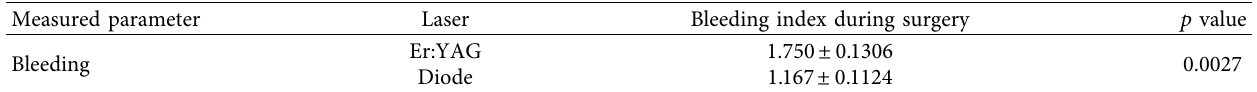
Table 6: Bleeding index of diode compared to Er:YAG lasers.